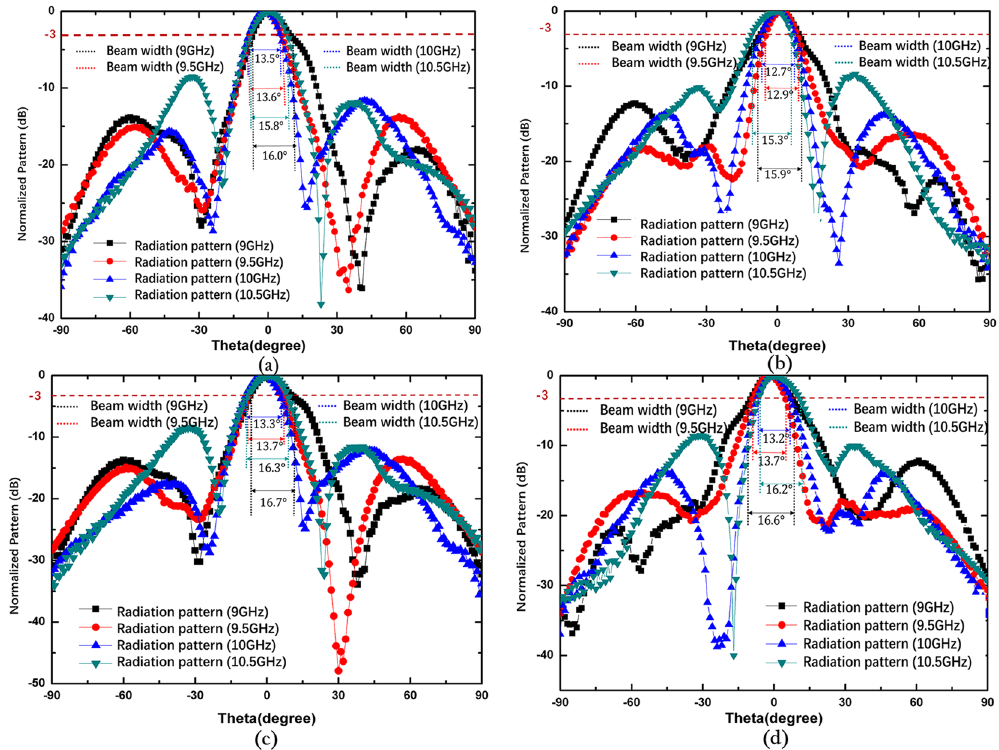
Figure 8. Simulated normalized radiation patterns and beam widths of the proposed MAs at four different frequencies of 9 GHz, 9.5 GHz, 10 GHz and 10.5 GHz. ( a ) Radiation patterns of the LHCP antenna in the X–Z planes. ( b ) Radiation patterns of the LHCP antenna in the Y–Z planes. ( c ) Radiation patterns of the RHCP antenna in the X–Z planes. ( d ) Radiation patterns of the RHCP antenna in the Y–Z